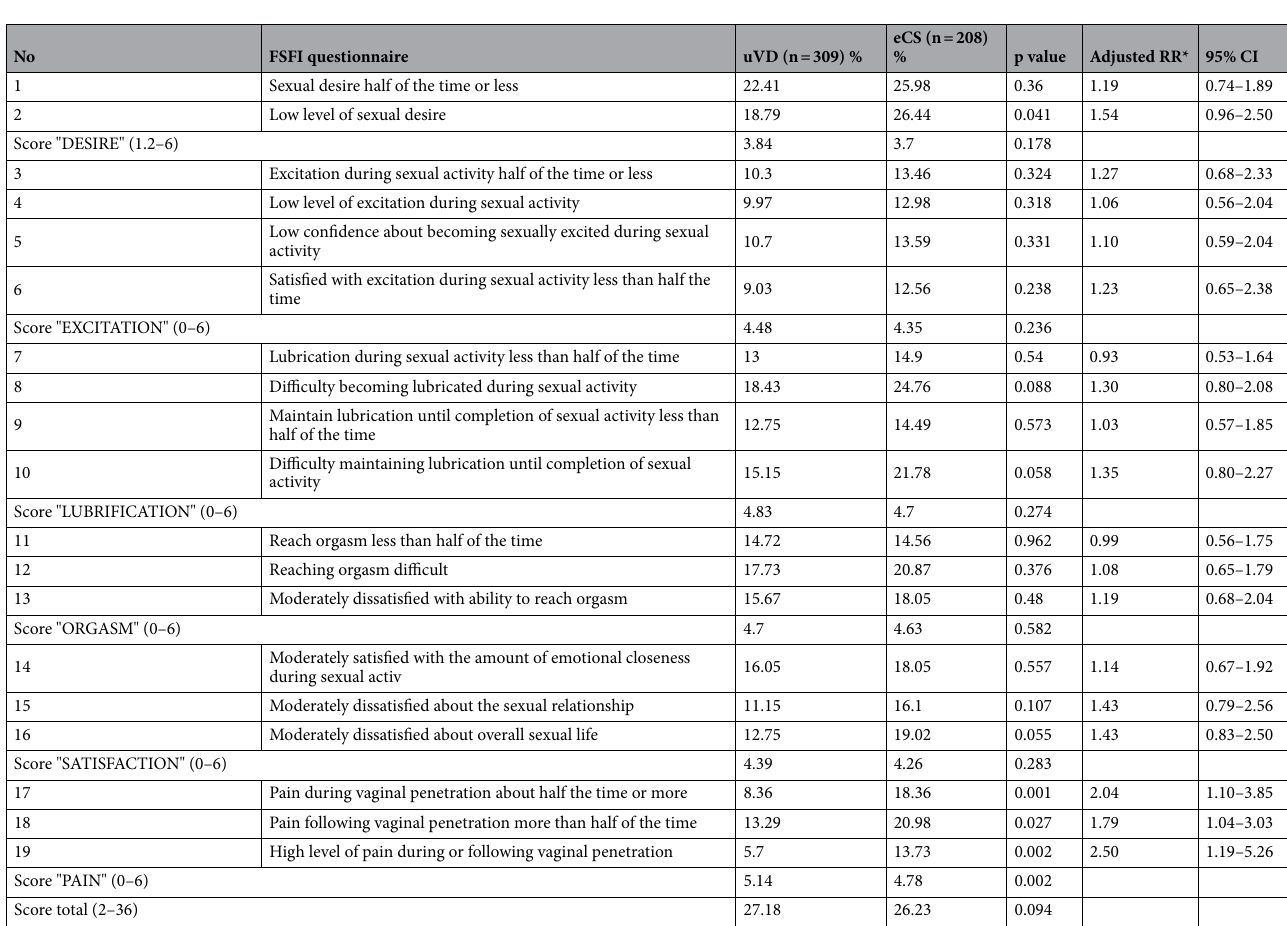
Table 5. Female sexual function index (FSFI). uvD uncomplicated vaginal delivery, eCS elective cesarean section, RR relative risk, CI confidence intervals. *Adjusted relative risks (RR) of presenting symptoms after a uncomplicated vaginal delivery compared to an elective cesarean section. Relative risks were adjusted for all socio-demographic and physical variables of Table